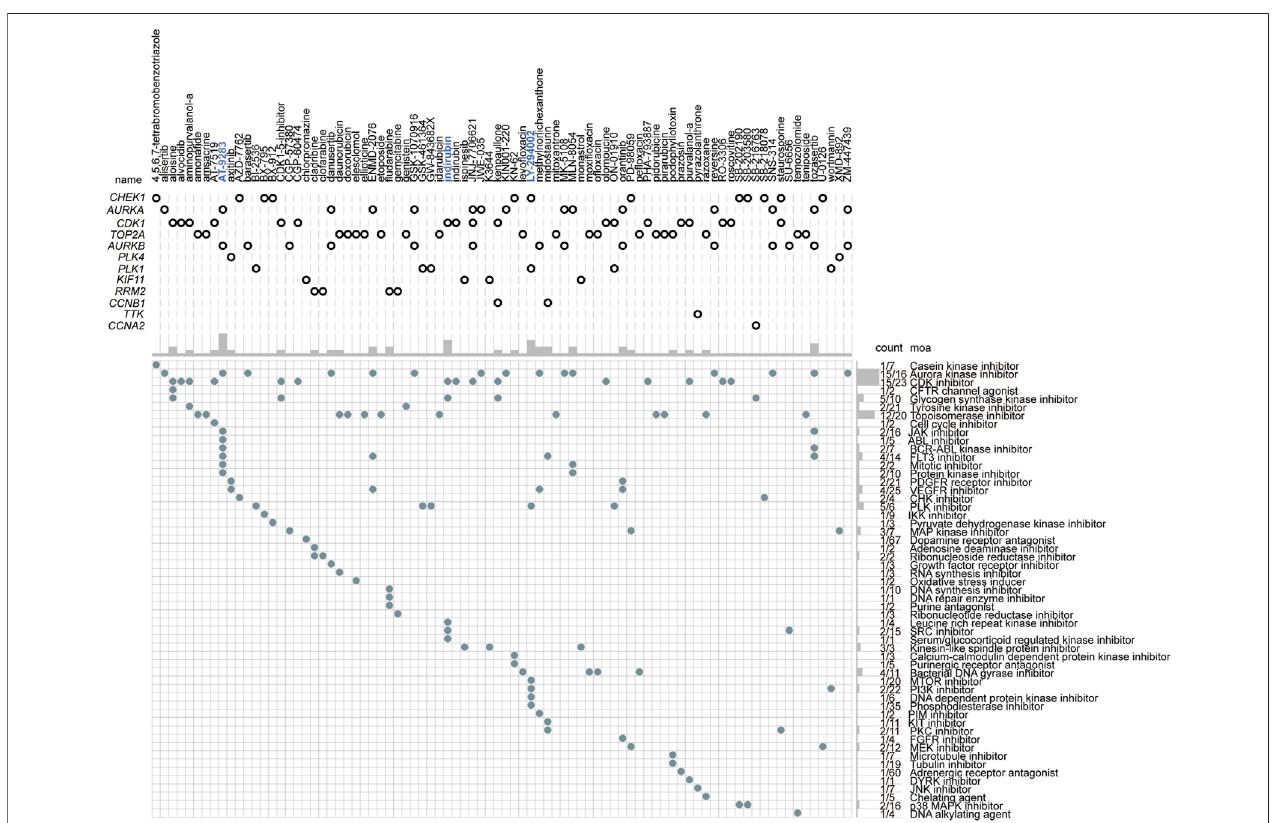
FIGURE 10 | The small-molecular chemotherapeutics forecast for patients with high-risk based on the hub genes. The blue label represents the most outstanding small-molecular perturbagens.